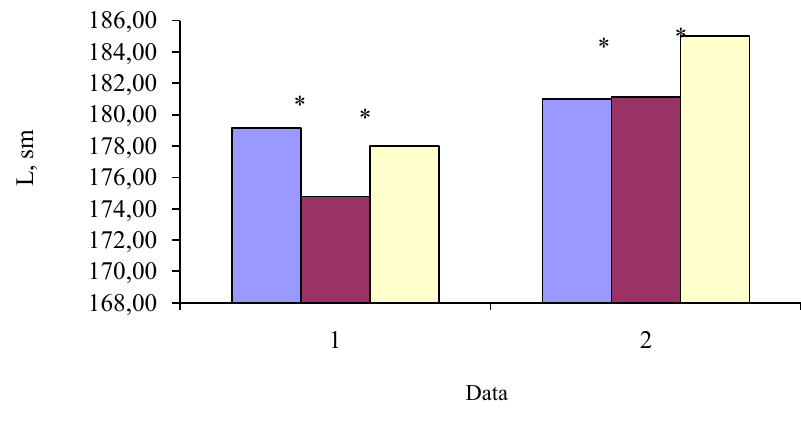
Fig.1. Anthropometrical indicators of elite sportsmen, who specialize in speed climbing (n=10), complex climbing (n=10) and mountaineering (n=6):